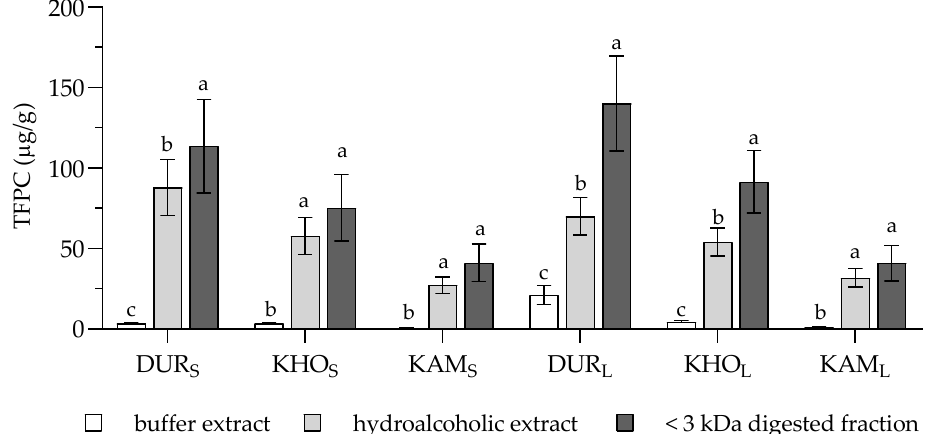
Figure 2. Total free PC content (TFPC) of buffer and hydroalcoholic extracts and <3 kDa digested fractions of the experimental cookies. TFPC represents the sum of total free PCs determined by uHPLC-MS n and is expressed as µg/g of cookie. Values are expressed as mean ± SD ( n = 4 for extracts, n = 3 for digested samples). Statistical analysis was by two-way ANOVA followed by Tukey’s HSD test. Within each cookie type, different letters indicate statistical significance among samples ( p < 0.05).